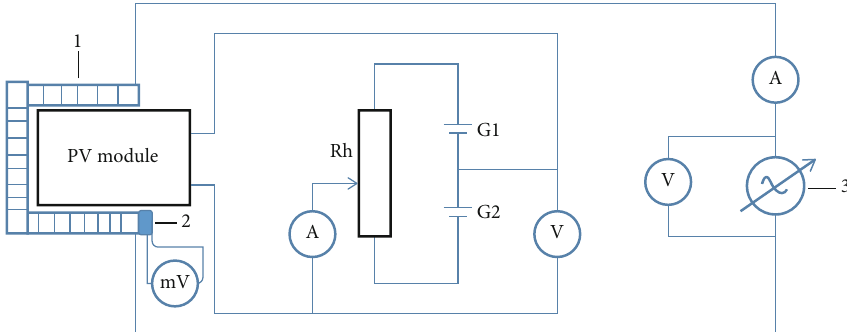
Figure 3: Layout of the experimental set-up. 1: inductance; 2: probe; 3: autotransformer.